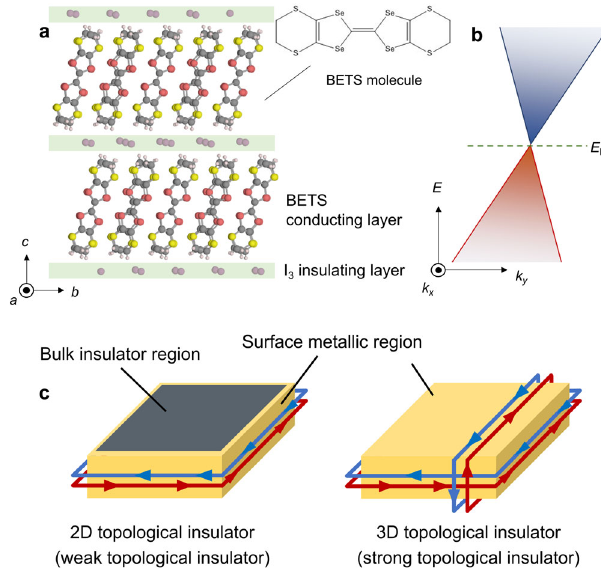
Fig. 1 | Crystal structure and predicted electronic states of α -(BETS) 2 I 3 . a Side viewofthecrystalstructureof α -(BETS) 2 I 3 .BETSmoleculesforming2D-conducting layers( ab -plane)areseparatedbynon-magneticinsulatinglayersofI 3 . b Schematic of the band structure of α -(BETS) 2 I 3 . The valence and conduction bands are touchingattheDiracpointandFermienergy E F isattheDiracpoint.TheDiraccone isslightlytiltedbecauseofthelowsymmetryofthecrystal 9 . c Schematicof2D-and 3D-TI states in α -(BETS) 2 I 3 . In the former, the metallic surface appears on the edge of the insulating ab -plane. In the latter, the metallic surface appears on all the crystal faces.